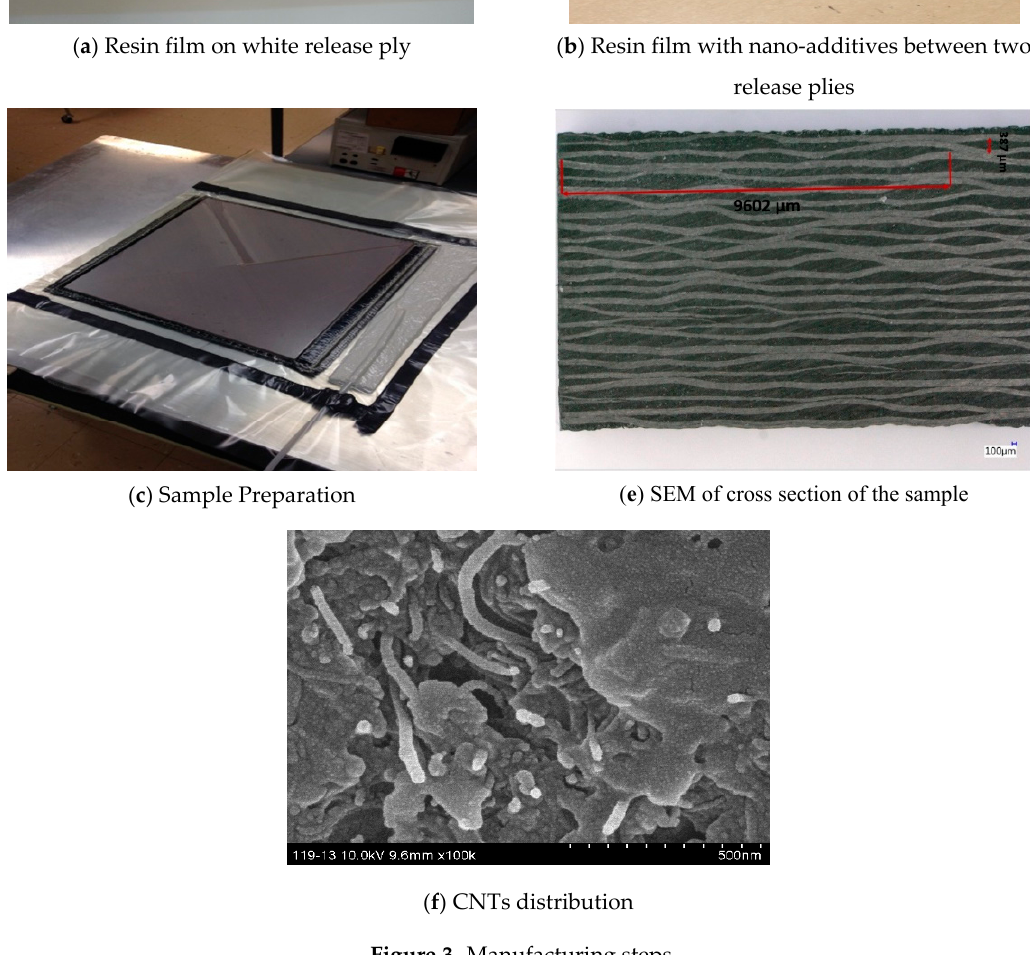
Figure 3. Manufacturing steps.